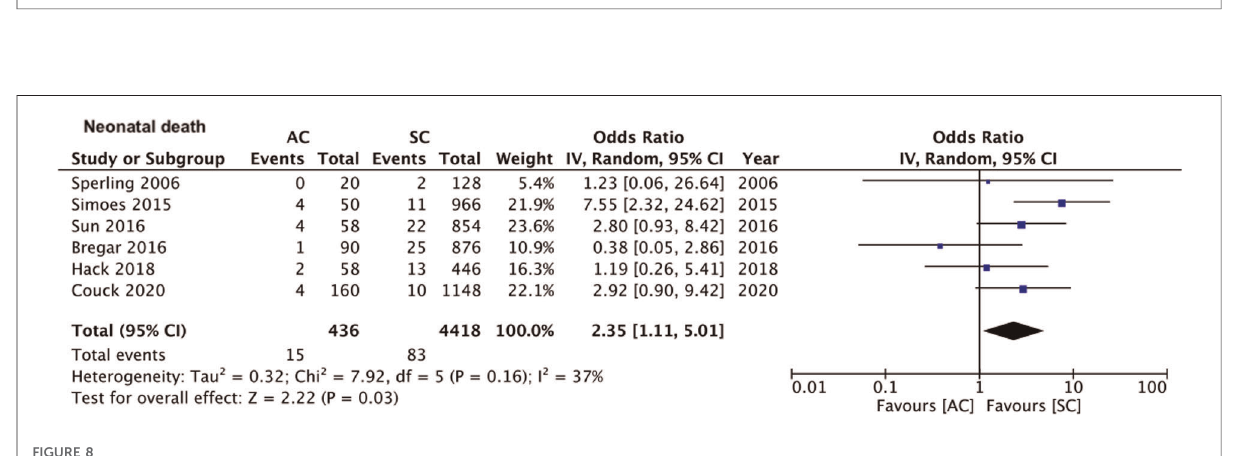
FIGURE 7 Meta-analysis of intra-uterine death between assisted and spontaneously conceived monochorionic twin pregnancies.